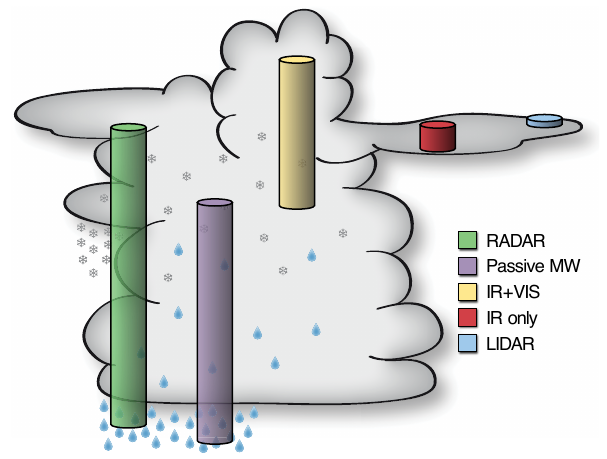
Fig. 1. A schematic figure of a thick cloud. The columns indicate approximately where in the vertical cloud the different measure- ment techniques are sensitive (figure by Oliver Lemke).